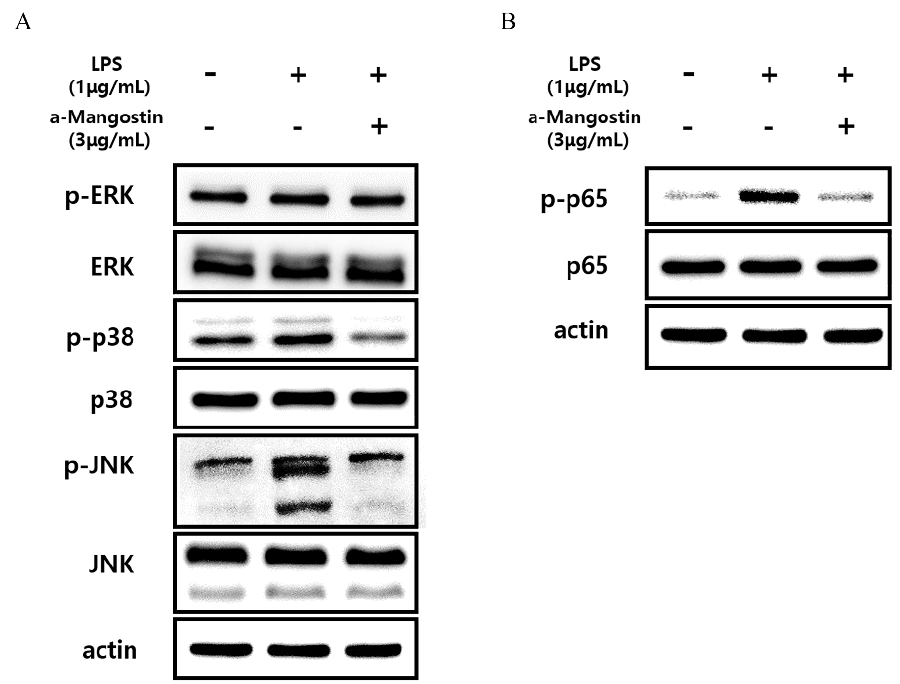
Figure 5. Western blot analysis monitoring the effect of α -MG on the activation of the MAPK and NF-kB signaling pathways in LPS-treated cells. The expression levels of ( A ) p-ERK, p-p38, p-JNK, and ( B ) p-p65 were evaluated.